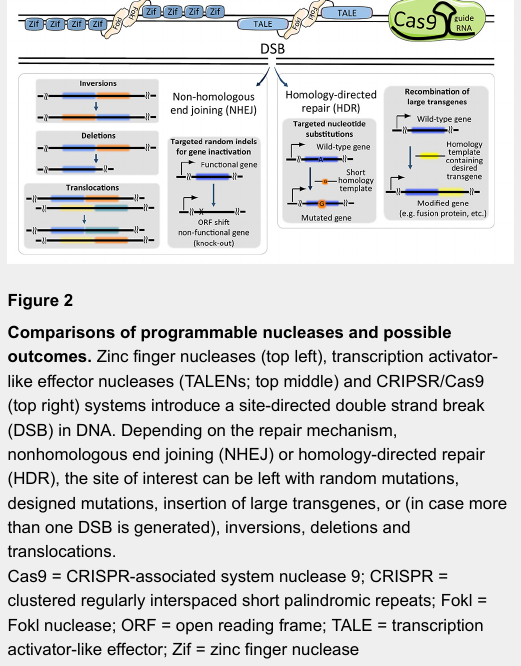
phenotype (table 1: BO4 vs BO1, BO2 and BO6). None